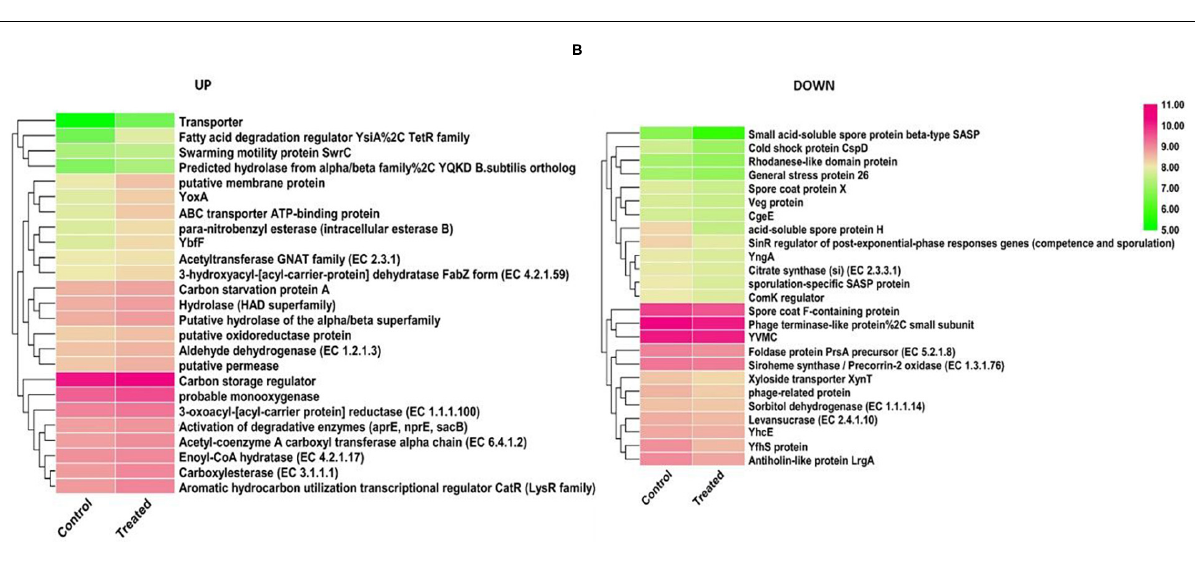
FIGURE 6 | The expression patterns of the DEGs identified between control and treated samples. The heat map represents the relative expression levels of 25 genes examined in up-regulated (A) and down-regulated (B) genes based on log2 FPKM